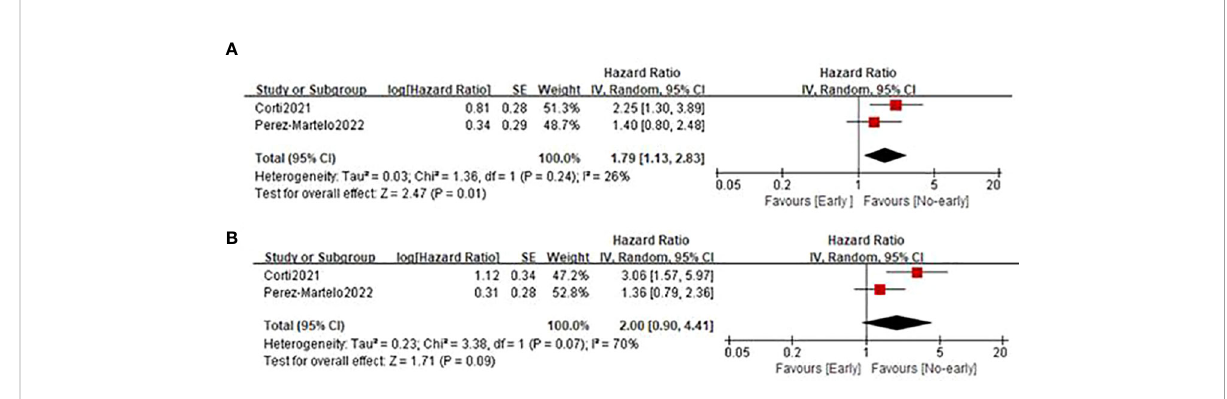
FIGURE 5 Forest plot assessing the relationship between PIV dynamics and survival outcomes including OS (A) and PFS (B)